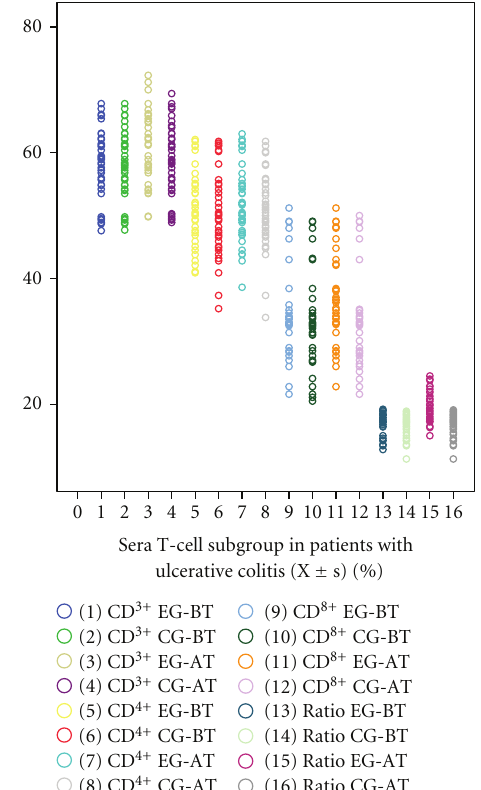
Figure 1: EG stands for experiment group; CG stands for control group; BT stands for “before treatment”. AT stands for “after treatment”. Ratio stands for the tenfold ratio of CD4 + T cells to CD8 + T cells. There was no significant di ff erence regarding the average values of T-cell subgroup between two groups before treatment and two months after treatment ( P > 0 . 05). However, the ratio of CD4 + T cell to CD8 + T cell in experiment group two months after treatment increased more than that in control group ( P < 0 .